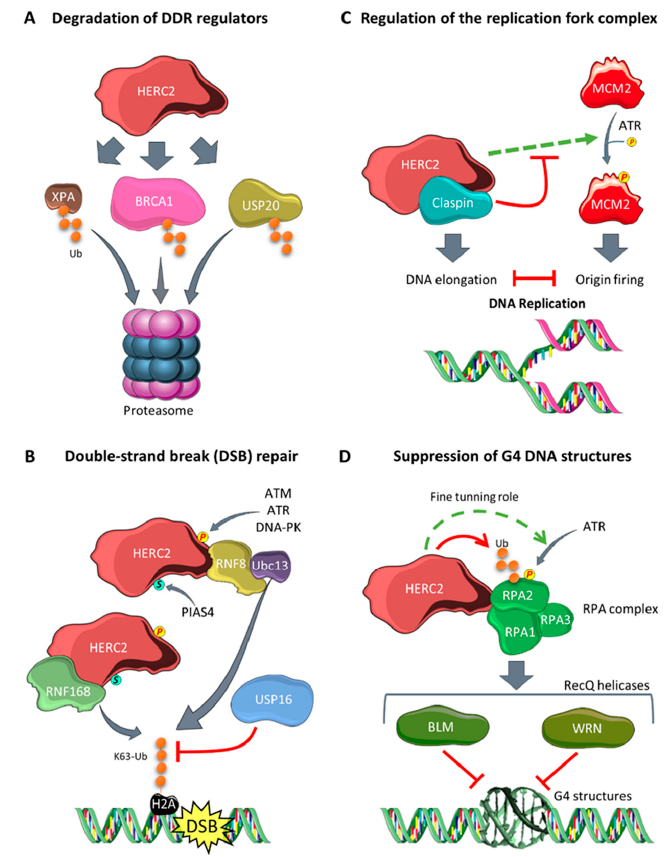
Figure 2. Involvement of HERC2 in the regulation of genomic stability: ( A ) HERC2 catalyzes the polyubiquitylationofdifferentDNAdamageresponse(DDR)regulators, suchasXPA,BRCA1,andUSP20, targeting them for proteasomal degradation; ( B ) upon double-strand break in the DNA, HERC2 is phosphorylated (by ATM, ATR, or DNA-PK) and SUMOylated (by PIAS4). These posttranslational modifications allow HERC2 to bind to RNF8, promoting the specific assembly of RNF8 with the E2 enzyme Ubc13. This allows the formation of K63 polyubiquitin chains in H2A-type histones flanking the double-strand break site. HERC2 interacts with and stabilizes RNF168, and this amplifies the ubiquitin chain formation in histones. By contrast, USP16 levels increase in a HERC2-dependent manner and negatively regulate H2A histone ubiquitylation to fine-tune chain formation; ( C ) HERC2 is present in the replication fork complex that regulates the balance between DNA elongation and origin firing. HERC2 facilitates ATR-dependent MCM2 phosphorylation, which enhances origin firing, and this is inhibited by Claspin, another HERC2-interacting protein. ( D ) G4 structures cause replication stress, and this leads to HERC2 promoting RPA2 phosphorylation via ATR. Then, HERC2 polyubiquitylates the phosphorylated form of RPA2, targeting it for proteasomal degradation, and thereby fine-tuning the total levels of phospho-RPA2. This mechanism is essential for assembling the BLM and WRN RecQ helicases to the RPA complex and for its later role in suppressing G4